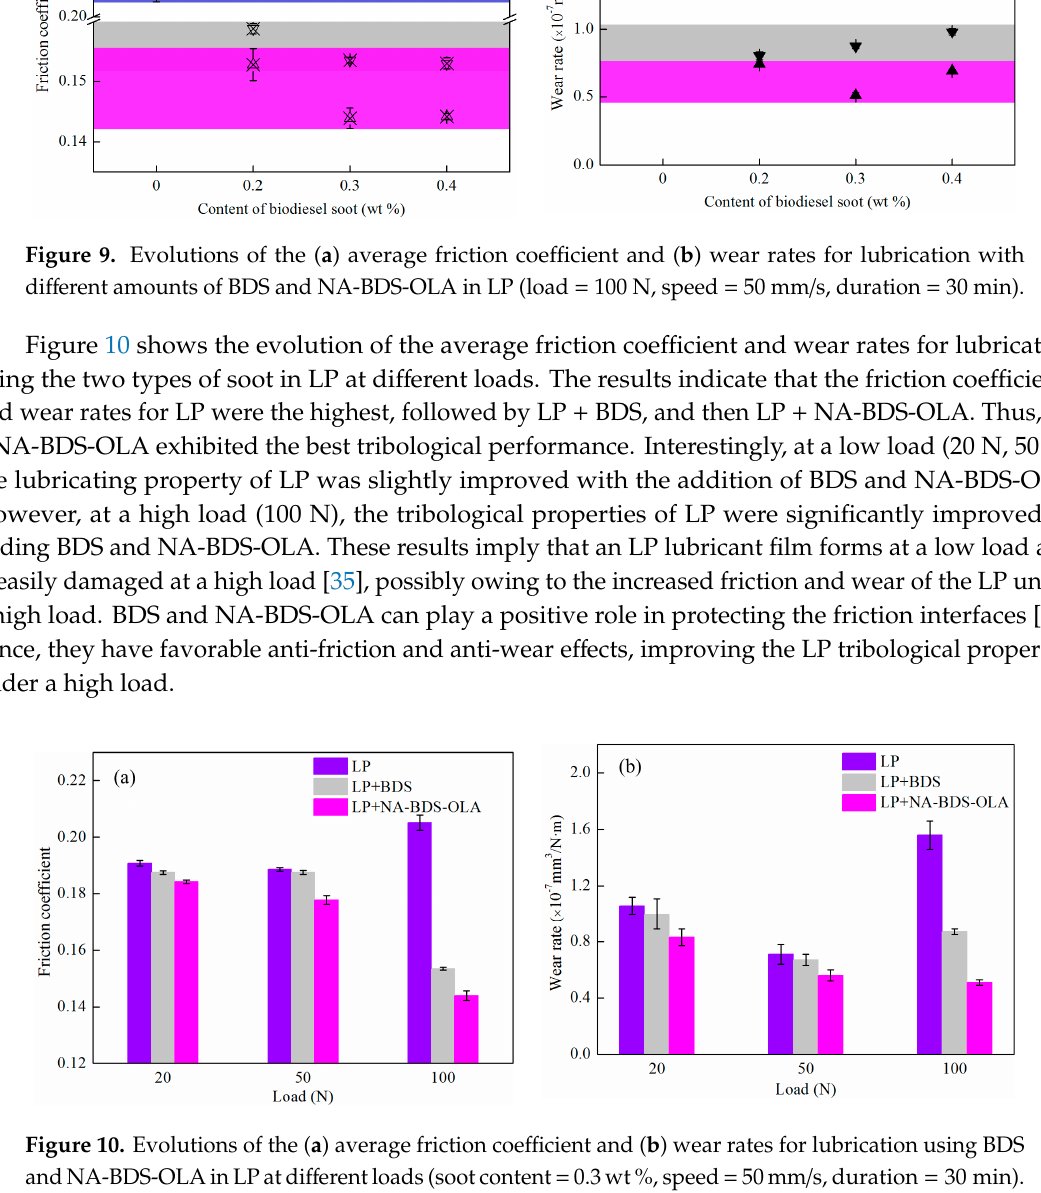
Figure 10. Evolutions of the ( a ) average friction coefficient and ( b ) wear rates for lubrication using BDS and NA-BDS-OLA in LP at different loads (soot content = 0.3 wt %, speed = 50 mm/s, duration = 30 min).